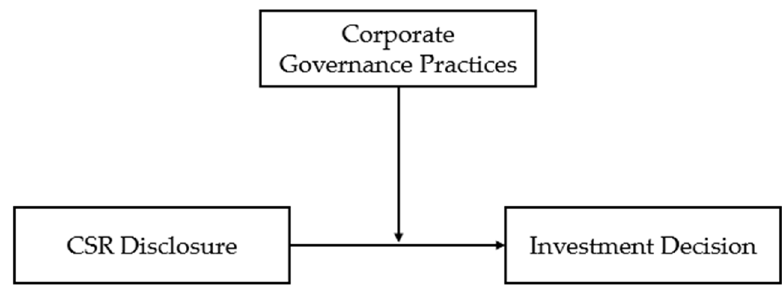
Figure 1. Conceptual